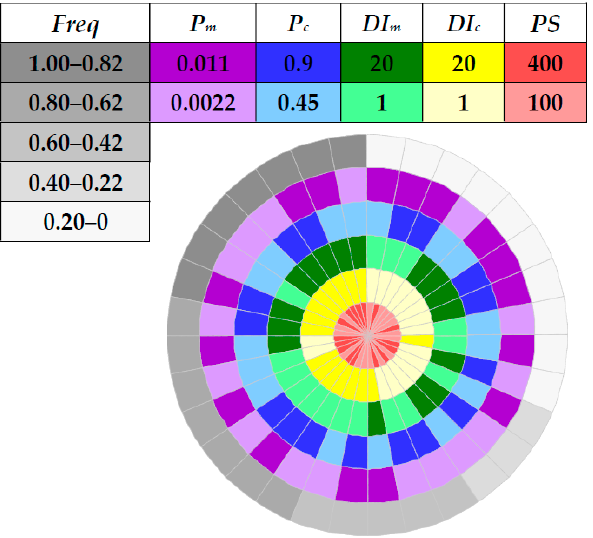
Figure 5. Parameterization of NSGA-II applied to the Balerma Irrigation Network (BIN) design problem.